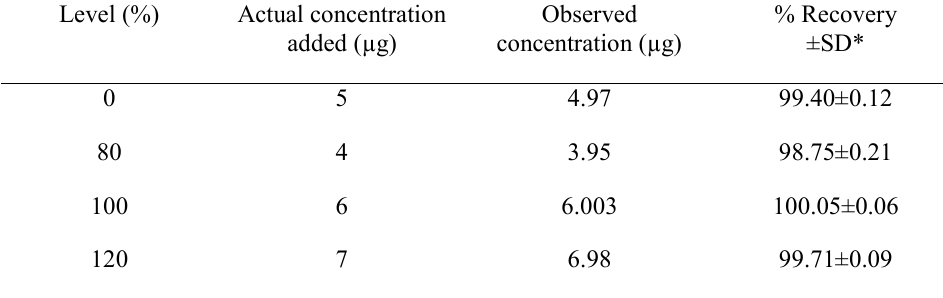
Table 2. Recovery of Fexofenadine.